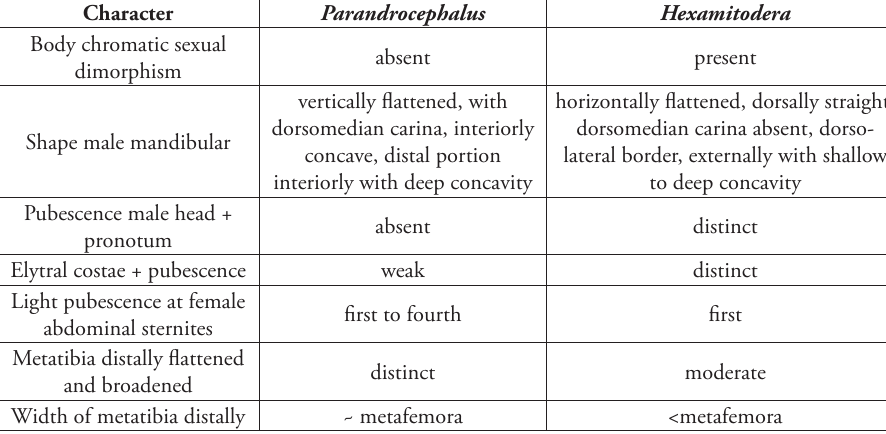
distinct moderate